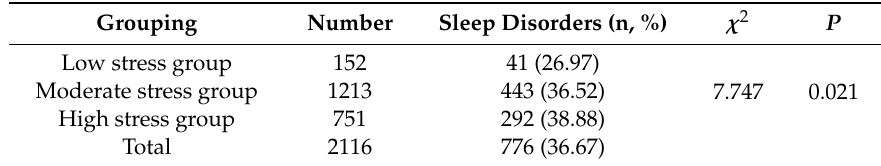
Table 2. Incidence of sleep disorders between groups with di ff erent occupational stress levels (%).